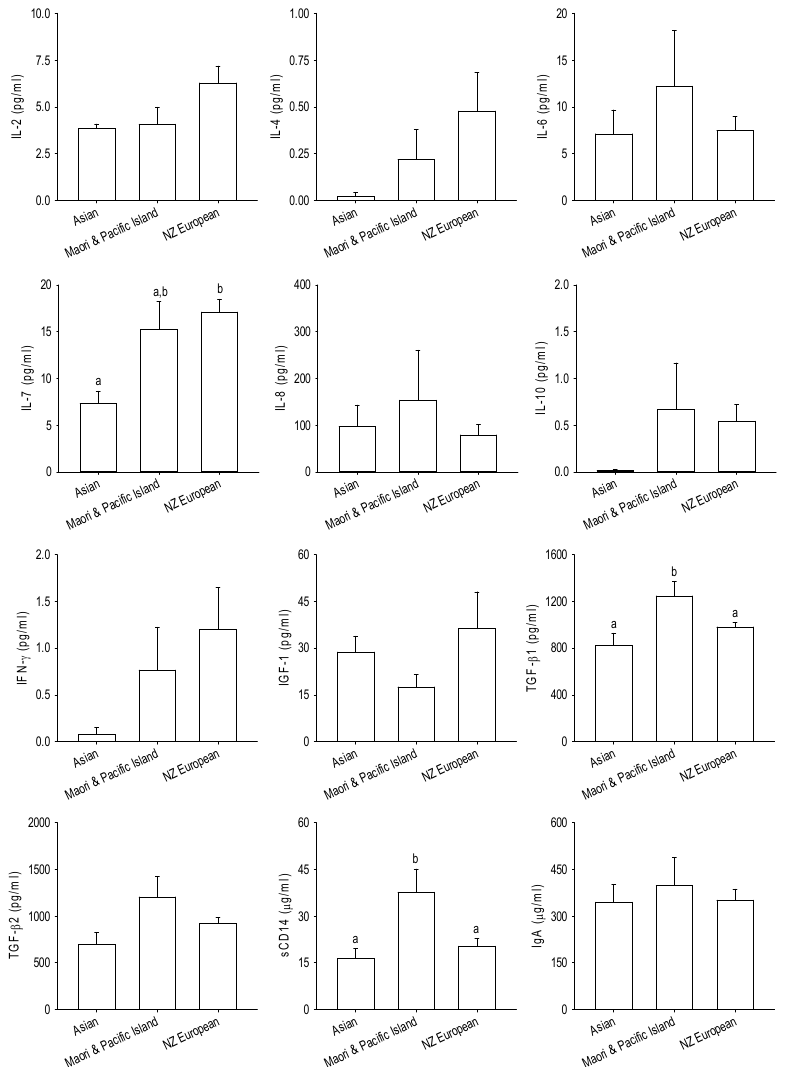
Figure 5. Immune-related proteins in the mother’s breast milk categorized according to the ethnicity. Data expressed as the mean ± standard error of the mean. Mean values with a di ff erent letter di ff er significantly, p < 0.05. IL—interleukin, IFN—interferon, IGF—insulin-like growth factor, TGF—transforming growth factor, sCD—soluble cluster of di ff erentiation, and